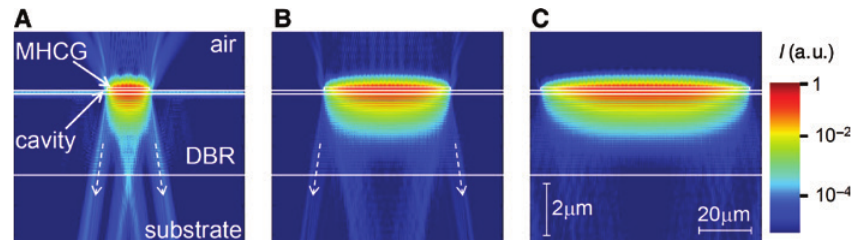
Figure 3: Cross-section in the yz -plane of a distribution of the normalized fundamental mode optical field intensity in M-D microcavities with (A) 20, (B) 60, and (C) 100 MHCG stripes. The positions of the MHCG, microcavity, and DBR are indicated. The parameters of the MHCG design are L = 163.9 nm (etching depth). The white dashed arrows illustrate the propagation of the higher diffraction orders. (duty cycle), and h M